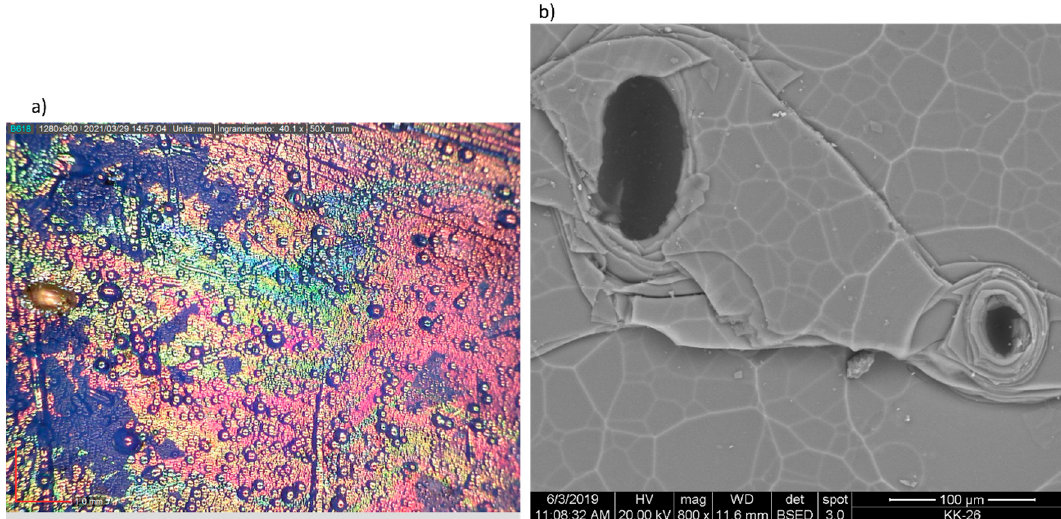
Figure 2. Iridescence on glass fragment KK_d1: ( a ) OM documentation, highlighting the occurrence of bubbles due to the leaching progress followed by pitting; ( b ) BSE image of the surface, with details of the cracking network and a micrometric pore, in the white rectangle.